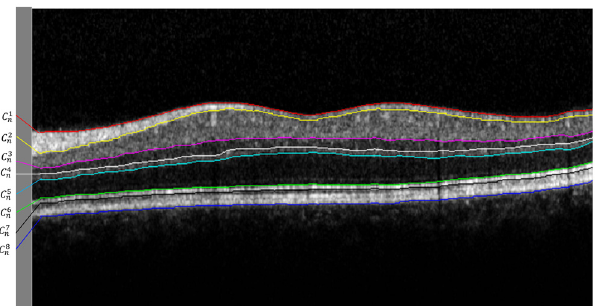
Fig 1. Exemplary OCT B-scan from Spectralis SD-OCT showing eight intraretinal layer boundaries labeled as C 1 n , C 2 n ... C 8 n . Note that boundaries are delineated with red, yellow, magenta, white, cyan, green black and blue solid lines, respectively and the notations are summarized in Table 1. A parafoveal scan is chosen in order to show all the layers that are segmented by OCTRIMA 3D.